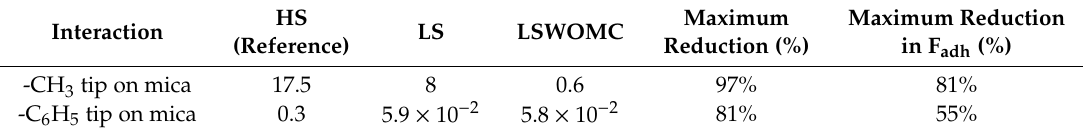
Table 5. Work of adhesion (aJ) in the presence of -CH 3 , -C 6 H 5 and -COOH coated tips on mica immersed in silica nanofluid dispersions and control solutions (AFB and 1 wt% NaCl).